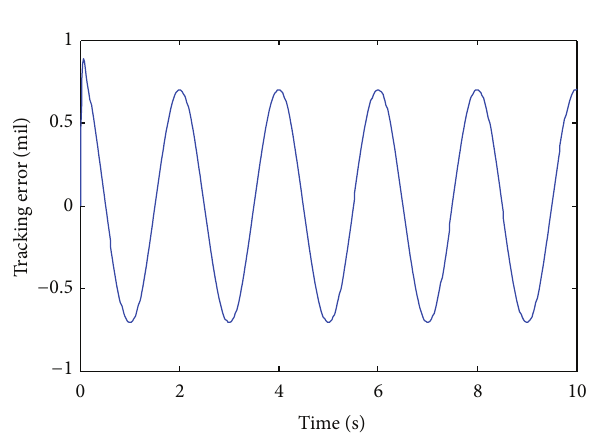
Figure 4: Step response of the control system.